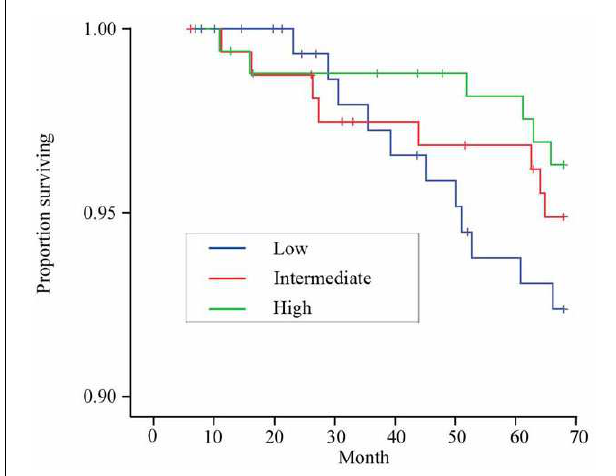
FIGURE 3 | Kaplan–Meier curves for survival of subjects according to the perception of dyspnea.